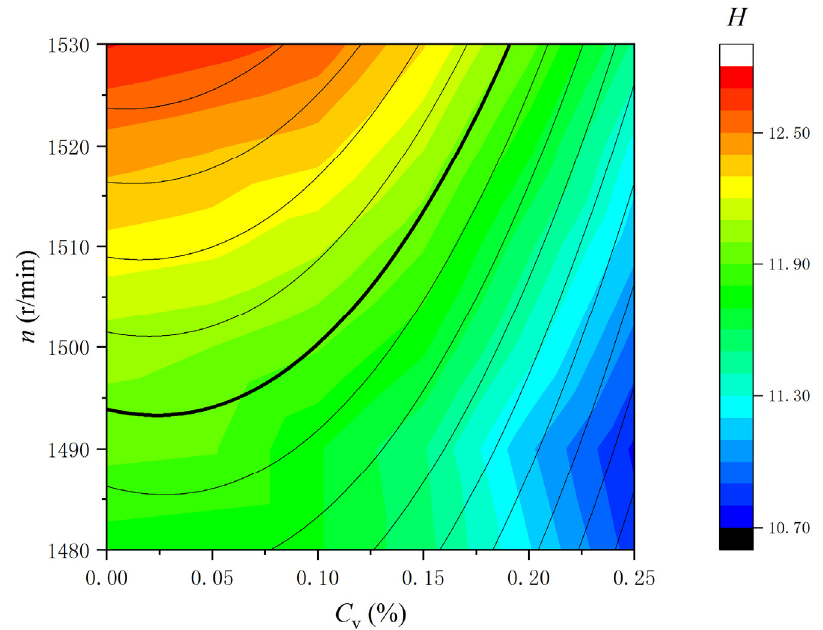
Figure 16. Equipotential head diagram of different solid concentrations and speeds.